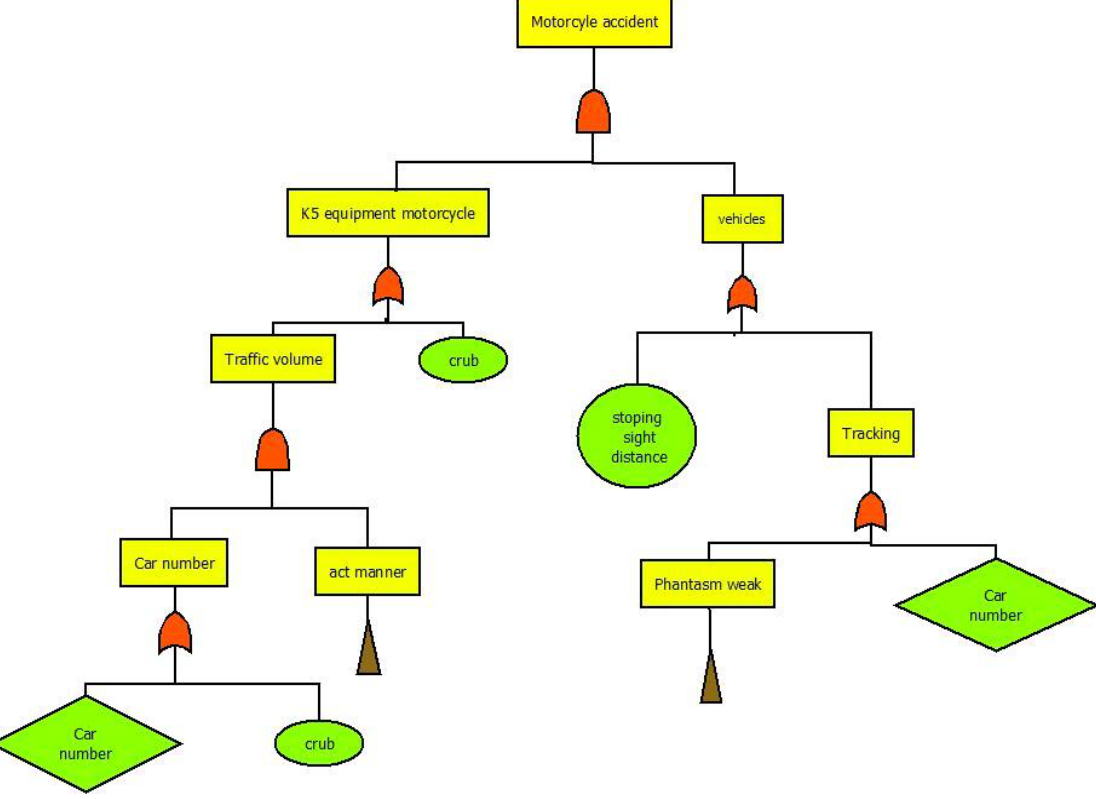
Fig. 5: Fault tree for vehicle-motorcycle accident at Qods